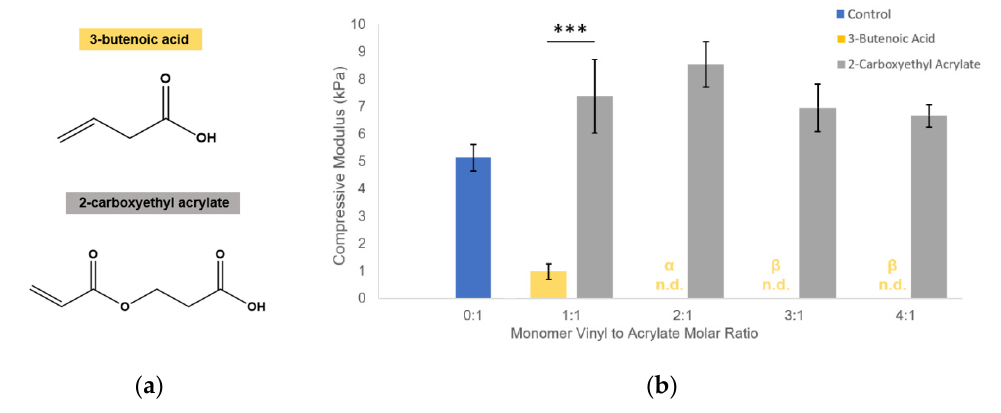
Figure 4. Allyl-presenting and acrylate-presenting monomers have significantly different effects on hydrogel modulus. ( a ) chemical structures of monomers; ( b ) compressive moduli of hydrogels with 3-butenoic acid and 2-carboxyethyl acrylate. Compressive modulus = slope of the stress–strain curve in the linear region following the toe region. Values reported as mean ± S.D. n = 4–6, *** p < 0.0001, indicating a statistically significant di ff erence. Statistical analysis evaluated by Student’s t -test. n.d. indicates no data, α : gels broke before evaluated strain region, β : gels did not form.